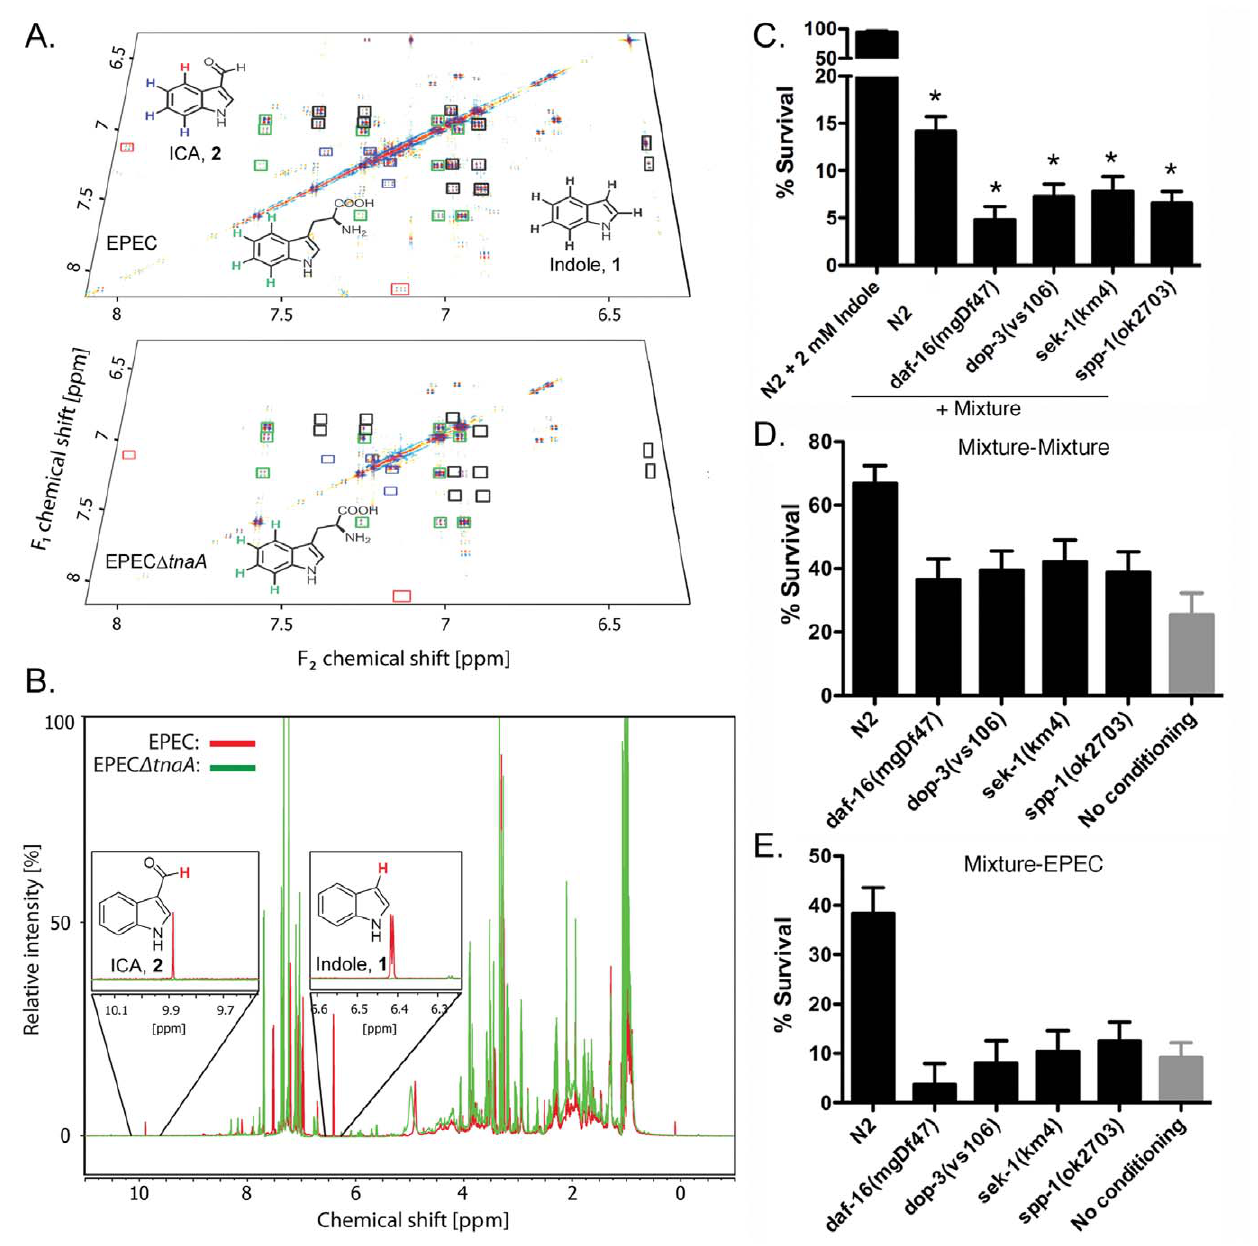
Figure 4. Identification of indole derivatives by two-dimensional NMR-based comparative metabolomics. ( a ) DANS overlay of the aromatic region of a dqfCOSY spectra obtained for the EPEC and EPEC D tnaA extracts highlights differentially present compounds in the EPEC extract. Crosspeaks representing colored protons in the shown indole structures are highlighted by correspondingly colored boxes. For example, the crosspeaks marked with a red box corresponds to a de-shielded protons of ICA, which is present in the EPEC spectrum but absent in the EPEC D tnaA spectrum. ( b ) Overlay of 1 H-NMR spectra from the EPEC extract (red) and the EPEC D tnaA (green). Signals representing indole (zoom of 6.4 ppm) and the aldehyde proton in ICA (at 9.9 ppm) are present in the EPEC spectrum but absent in the EPEC D tnaA spectrum. ( c ) Reconstitution of killing with 2 mM indole in combination with 0.6 mM ICA and 0.2 mM IAA. Mean + / 2 SEM are shown; * corresponds to p , 0.01 with respect to N2. ( d,e ) Pre- exposure of N2 or various mutants to the indole/ICA/IAA mixture for 30 minutes followed by a 3 hour waiting period on OP50, and then a 3 hour challenge with either the mixture ( d ) or EPEC ( e ). Note that killing and conditioning with the mixture closely resembles that seen with EPEC, and utilizes the same gene products in C. elegans . In d-e, mean + / 2 95% confidence intervals are shown. Lack of overlapping error bars indicates significance at the 5% level. doi:10.1371/journal.pone.0054456.g004 Thus, EPEC and EHEC appear to share LEE regulatory Indole Derivatives Regulate Shiga Toxin Production in pathways that are sensitive to indole and its derivatives. EHEC and EAEC Release of STX1 and STX2 by EHEC and EAEC strains causes hemorrhagic colitis and hemolytic uremic syndrome, and is